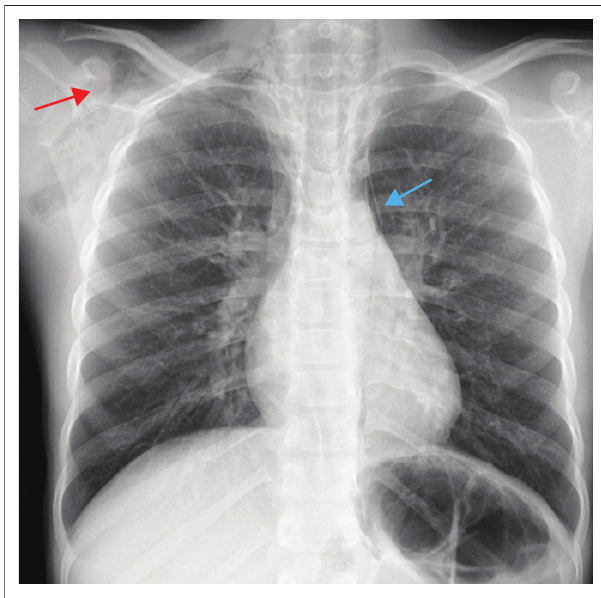
FIGURE 1: Chest radiograph on admission demonstrating subcutaneous emphysema (red arrow) and pneumomediastinum (blue arrow).